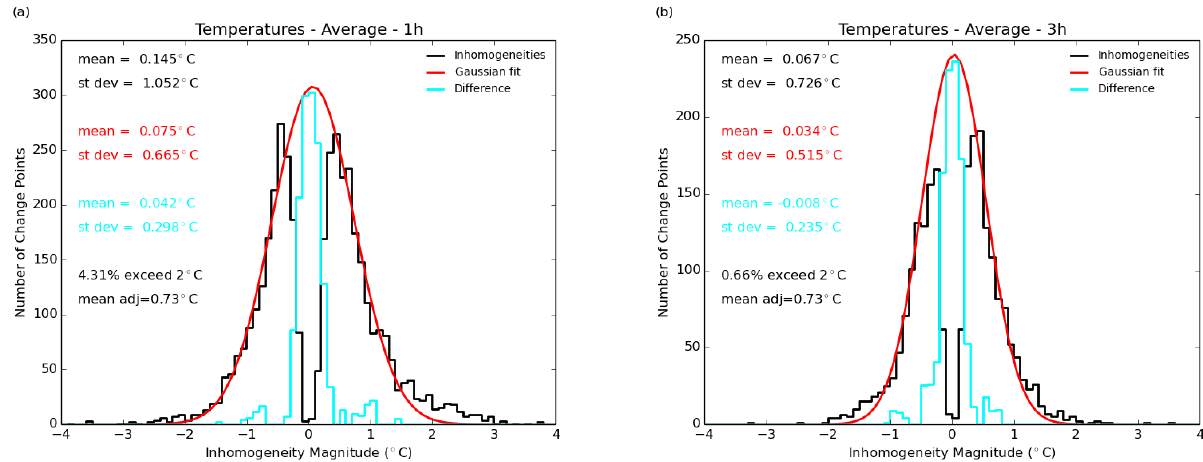
Figure A1. The distribution of the inhomogeneity magnitudes for monthly-mean temperatures for stations which report (a) hourly and (b) three-hourly. The distributions have been fitted with a Gaussian (red), and the difference between the data and the Gaussian is shown in blue.